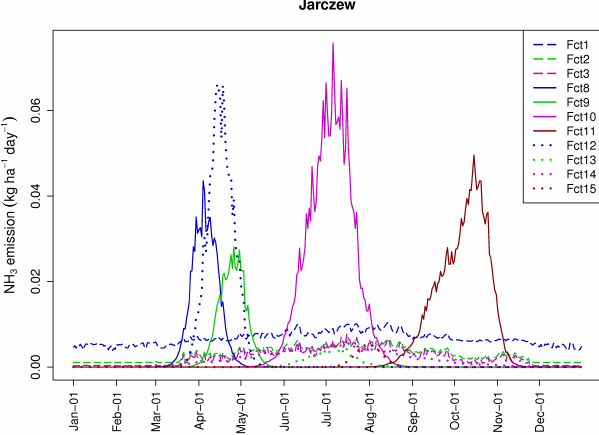
Figure 3. Time series of the seasonal variation in emissions (POL- REGUL run) for various agricultural emission categories in Jar- czew. Description in the legend concerns emission from functions (Fct) described in Table